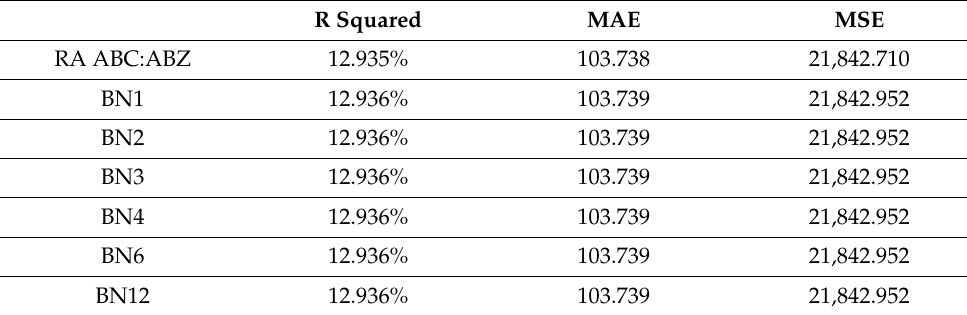
Table 9. RA and BN Toy Example Results.